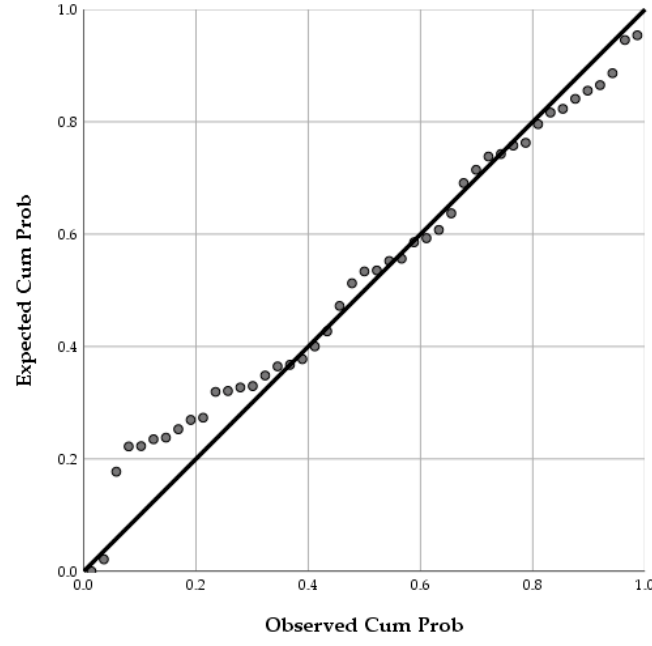
Figure 4. Normal P-P Plot to test the model’s residuals distribution.